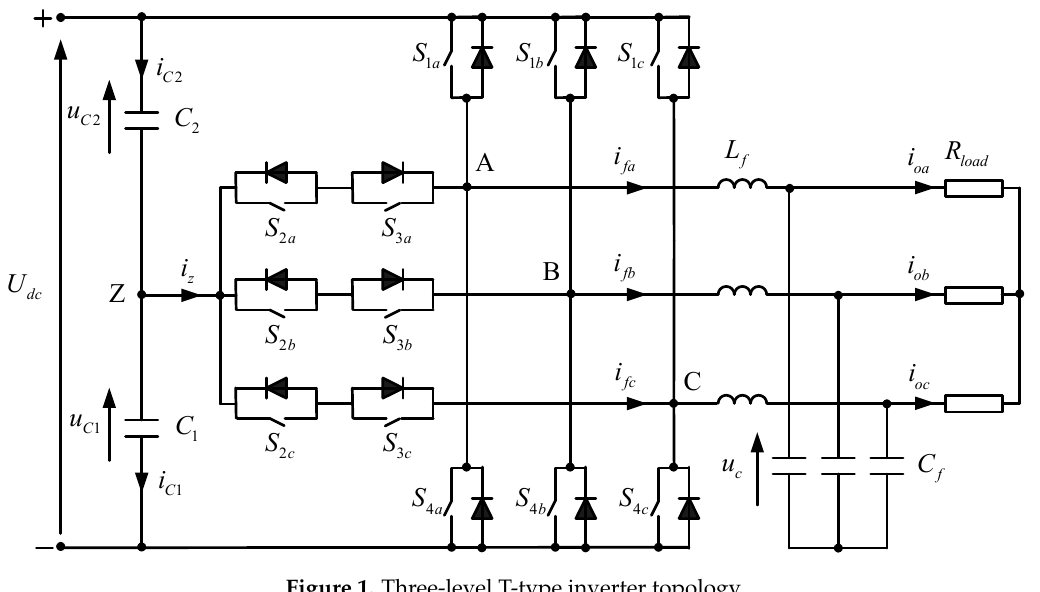
Figure 1. Three-level T-type inverter